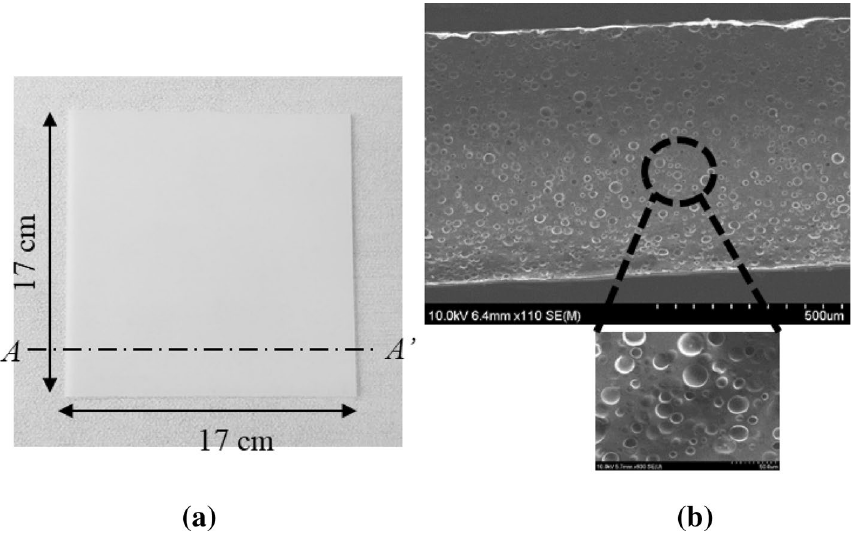
Figure 1. The present porous PDMS layer, fabricated at t e = 150 °C and WMR = 0.5: ( a ) top view; ( b ) SEM of the cross-section A-A’ of figure ( a ).